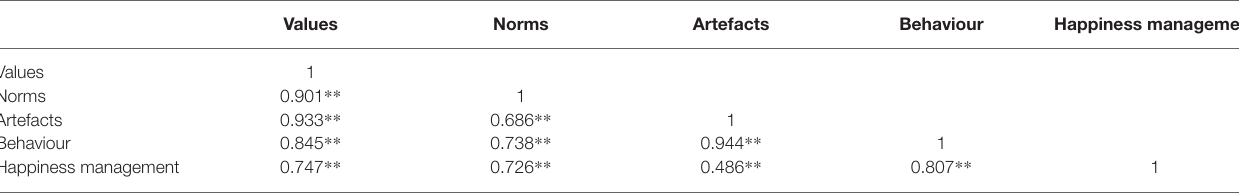
TABLE 5 | Correlations between constructs.